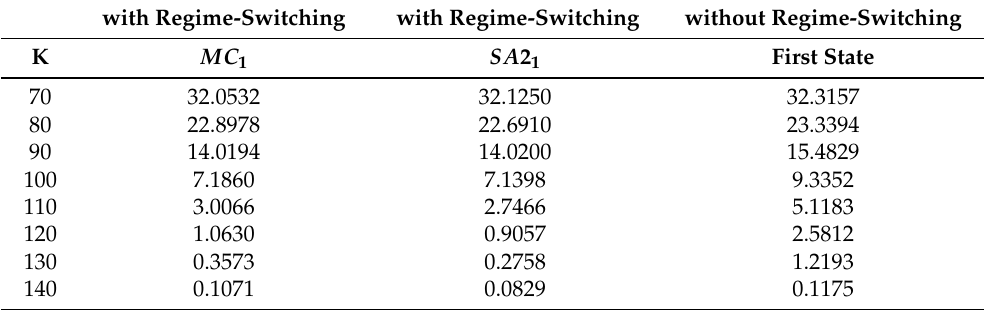
Table 2. Call option prices when T = 1, N =